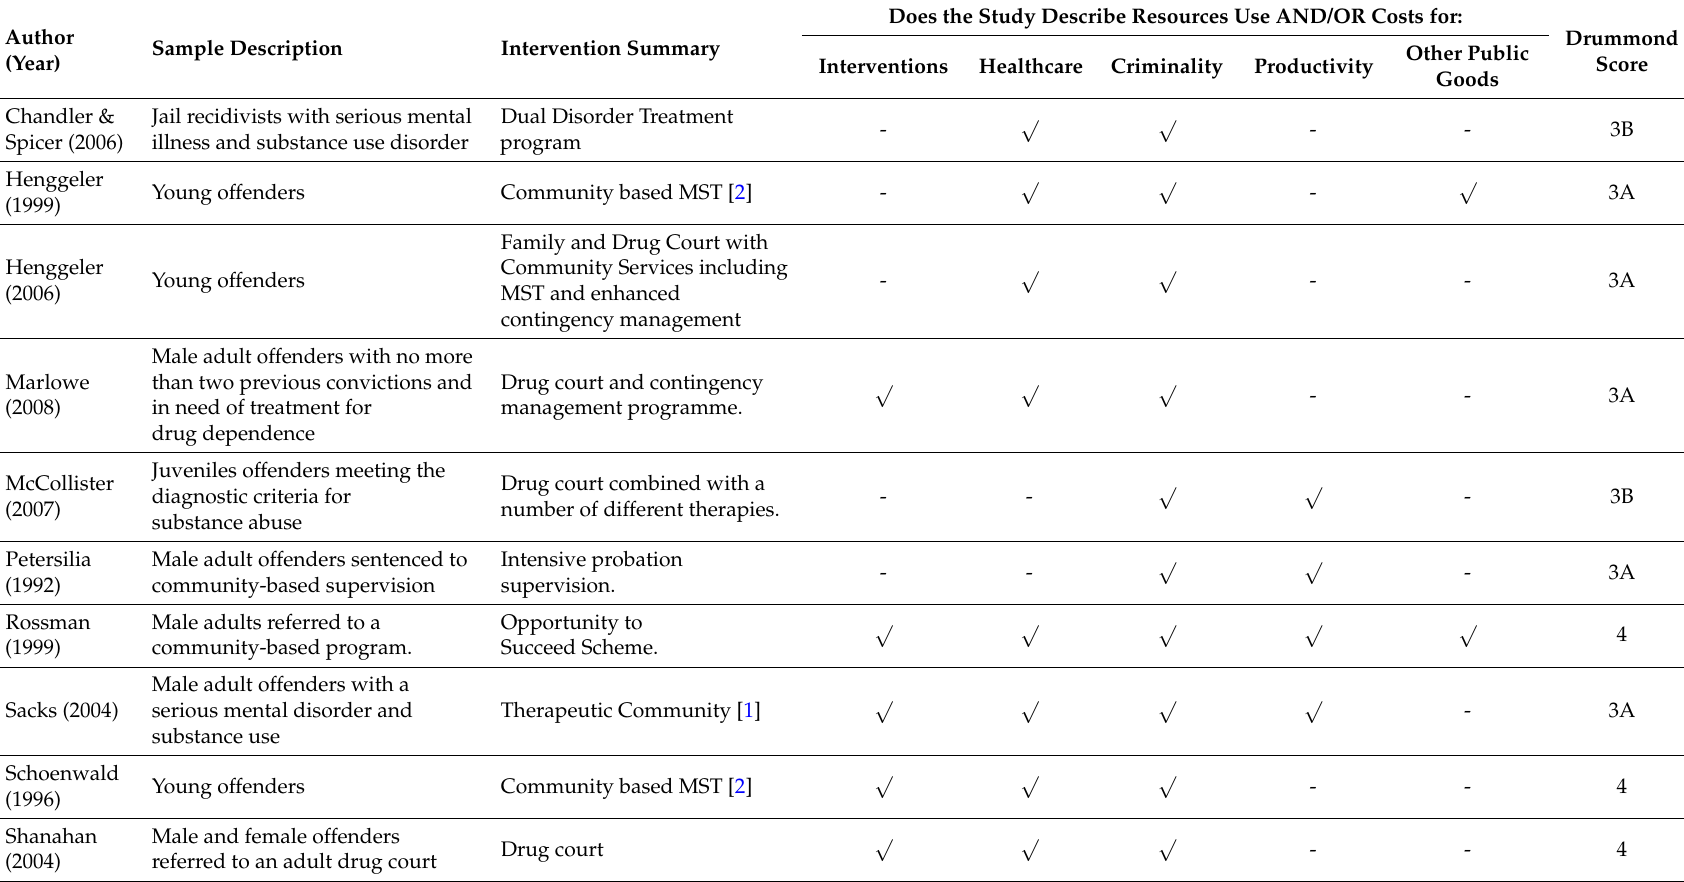
Table 2. Available economic information (resource use and/or cost) and evaluation type according to Drummond Classification Scheme (see Table